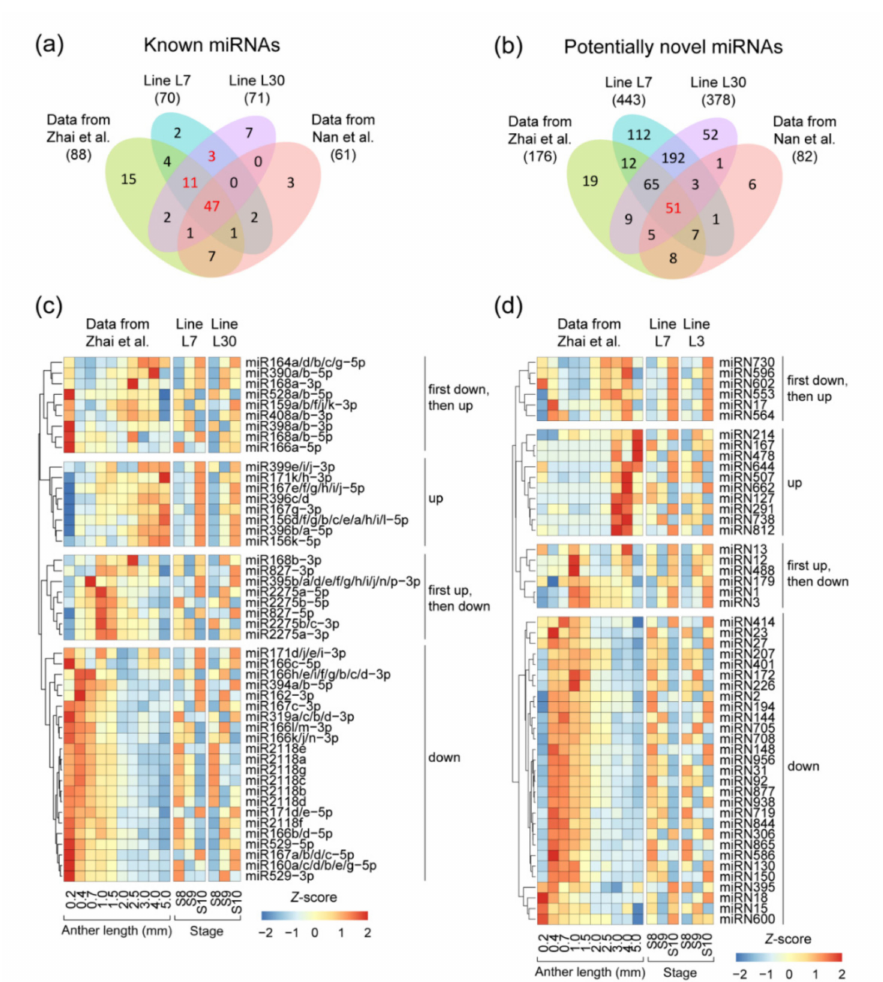
Figure 2. Identification of transcribed microRNAs (miRNAs) in the developing maize anther. Numbers of identified ( a ) known and ( b ) potentially novel miRNAs were shown. The maize anther small RNA transcriptome data from two previous studies was reanalyzed here [37,38]. Sixty-one known miRNA groups and 51 potentially novel miRNA groups were used in the following analysis (marked in red). Transcription expression patterns of identified ( c ) 47 known and ( d ) 51 potentially novel miRNAs were categorized into four classes based on the reanalyzed results of Zhai et al.’s data with 10 anther developmental stage points [38]. Transcription expression levels of each miRNA group were normalized to Z -scores for data from Zhai et al., line L7 and line L30